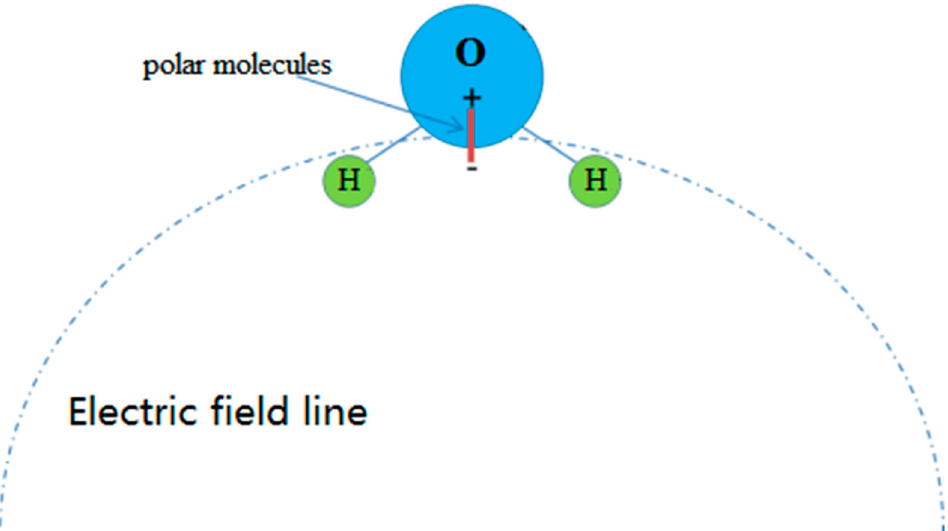
Figure 11. Illustration of deflection of dipole moment under action of electric field.